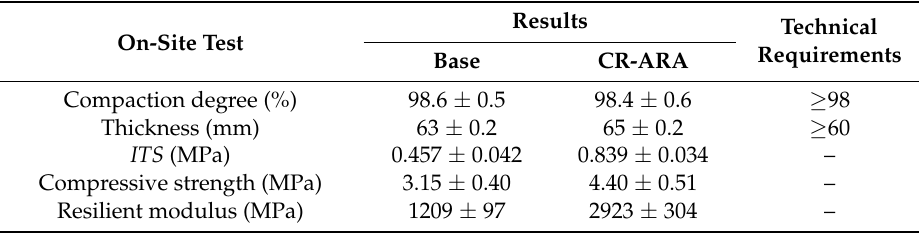
Figure 13. Equipment used for on-site coring and measurement: ( a ) core-drilling machine; ( b ) information of cored specimen. Table 9. Related properties of cored specimens from the test road.